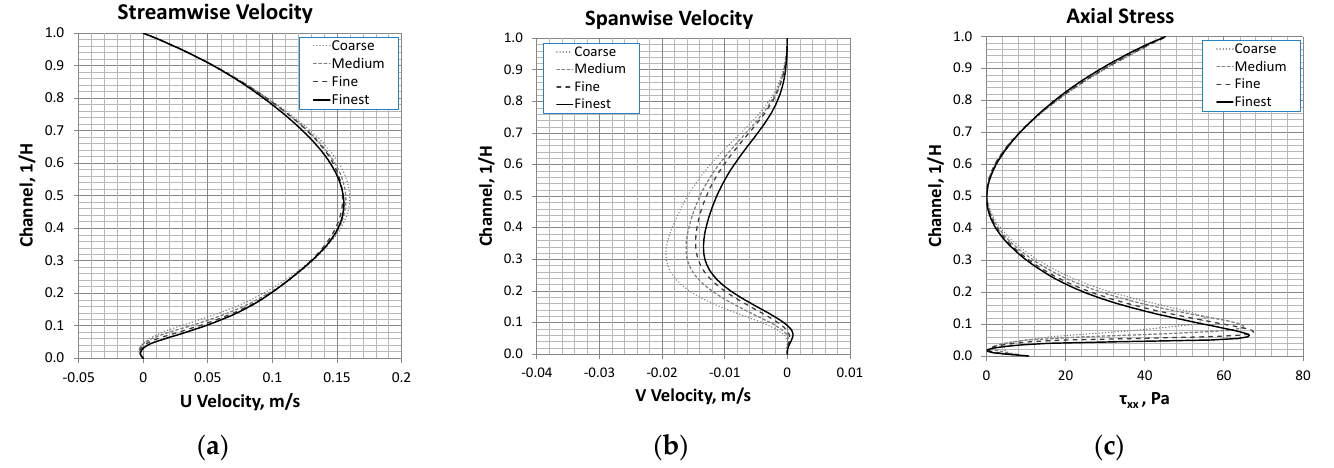
Figure 3. Grid convergence analysis, Wi = 1.0, El = 100, β = 0.1: ( a ) horizontal velocity; ( b ) vertical velocity; ( c ) axial stress. Figure 3a compares the streamwise velocity component for the four grids evaluated. The weighted average deviation error outside the vortex for the fine grid is 1.3% and 5.5% inside the vortex. Similarly, Figure 3b compares the spanwise velocity component for the same four grids. The weighted average deviation error outside the vortex is 14% and 26% inside the vortex, respectively (in both cases, note the very low actual value of the pre- dicted velocity). Lastly, Figure 3c compares the axial stress. The weighted average devia- tion error outside the vortex is 4.0% and 8.3% inside the vortex, respectively. Similar analyses were conducted for many cases, including those with inertial vorti- ces located downstream of the bend corner. In a typical high Reynolds number case, Re = 100, the weighted average deviation errors of all variables are significantly smaller. For the streamwise velocity component, the weighted average deviation error outside the vor- tex for the fine grid is 0.02% and 0.4% inside the vortex, respectively. For the spanwise velocity component, the weighted average deviation error outside the vortex is 0.09% and 0.5% inside the vortex, respectively. Additionally, for the strain rate, the weighted average deviation error outside the vortex is 0.04% and 0.28% inside the vortex, respectively. In general terms, it was found that predicting the location and length of the vortex is the most significant challenge in attaining grid convergence. Outside the vortex and far from it, the grid convergence index (GCI) for the fine grid is excellent, ranging from 0.0 to 1.5% in all variables. Within the vortex, the GCI for the fine grid is acceptable, ranging from 0.1% to 25% in all variables. Again, it should be noted that actual values for the spanwise velocity and the normal stress within the vortex are significantly smaller when compared to the streamwise velocity and the axial stresses, by two to three orders of mag- nitude. The mesh and grid convergence analyses were conducted following the Procedure for Estimation and Reporting of Uncertainty Due to Discretization in CFD Applications by Roache et al. [23]. The formation of vortices in polymer flow has been studied extensively in planar contractions and the size and strength have been shown to be strongly dependent on the mesh [15,24,25]. For example, the effect of mesh refinement on the size of the vortices was highlighted by Alves et al. [26] when developing benchmark solutions for the flow of Ol- droyd-B and PTT fluids in planar contractions. They found that a very high degree of mesh fineness was required to obtain accurate results with the Oldroyd-B fluid, while the PTT fluid in general did not require the finest meshes. These authors relied on Richard- son’s extrapolation to measure the level of convergence. 3. Results 3.1. Newtonian Flow